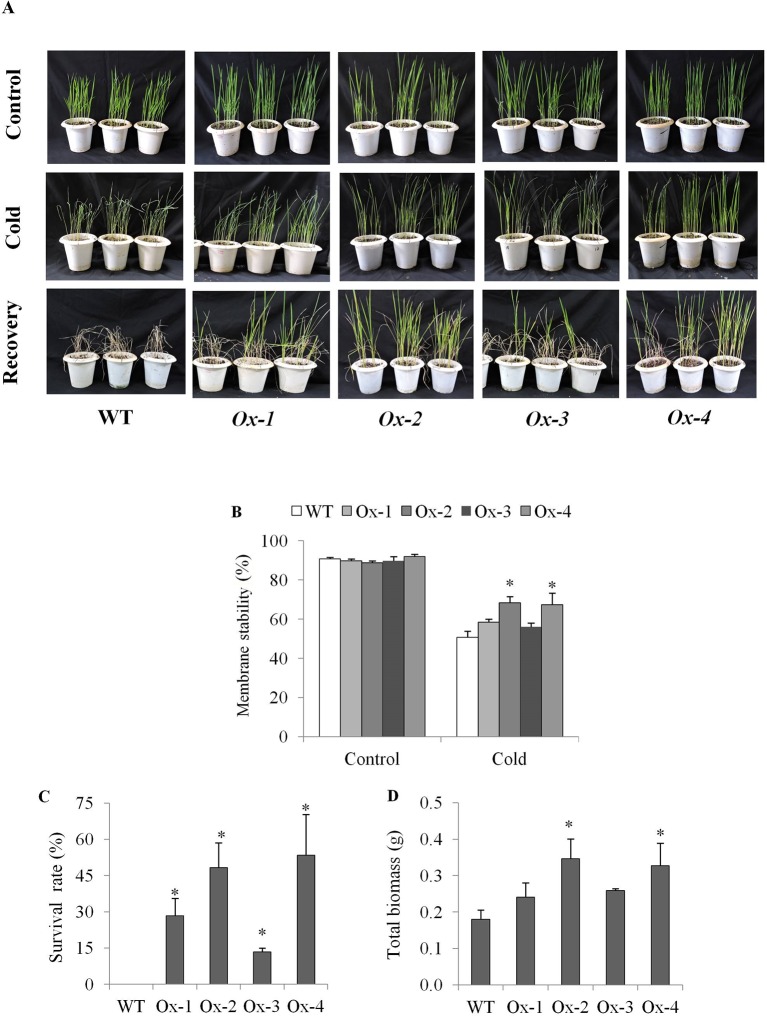
Cold stress tolerance of OsPYL10 overexpressing transgenic rice seedlings. (A) Photograph showing phenotype of seedling before and after stress and recovery. 25 days old seedlings were exposed to 15°C for 48 h (acclimation) followed by cold stress at 6°C for 48 h. These plants were recovered at normal temperature for one week and then photographs were taken. (B) Membrane stability at the end of cold stress treatment. (C, D) Seedling survival rate and total biomass after 7 days of cold stress recovery. The experiments were performed with three independent biological replicates (3 pots each with 20 seedlings). Value shown in graph are mean of biological replicates (n = 20). Error bar indicates ±SE. *means P < 0.05.